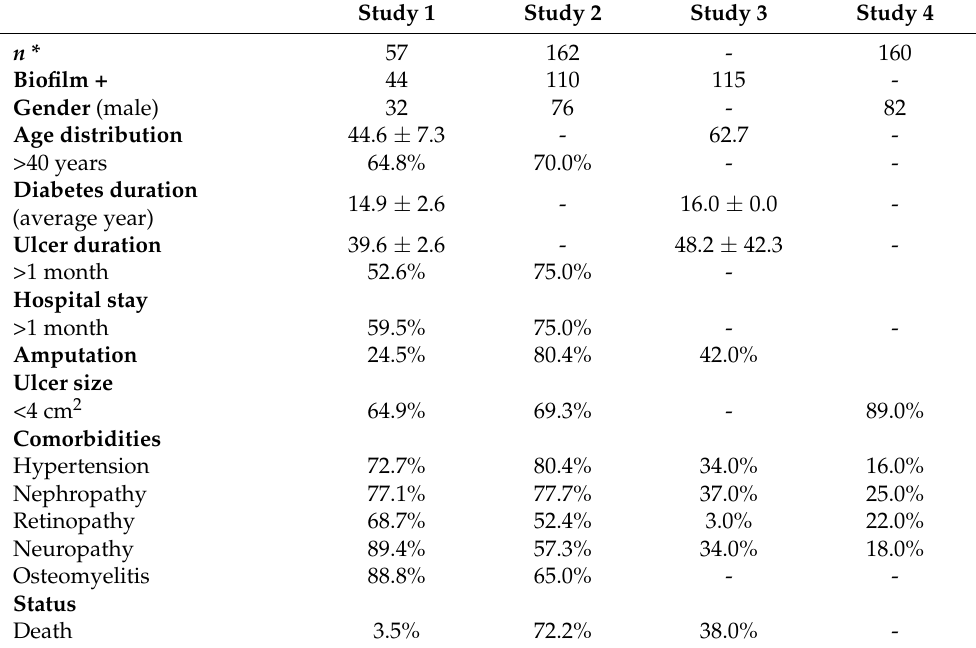
Table 3. Relationship between biofilm formation and clinical profile. Comparison of 4 studies